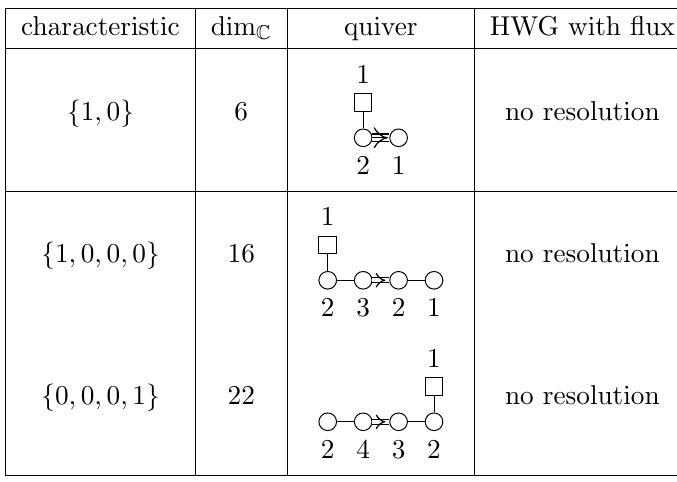
Table 7 . Coulomb branch quiver gauge theories for the exceptional algebras G 2 and F 4 : realisations of the (closures of the) nilpotent orbits of characteristic height